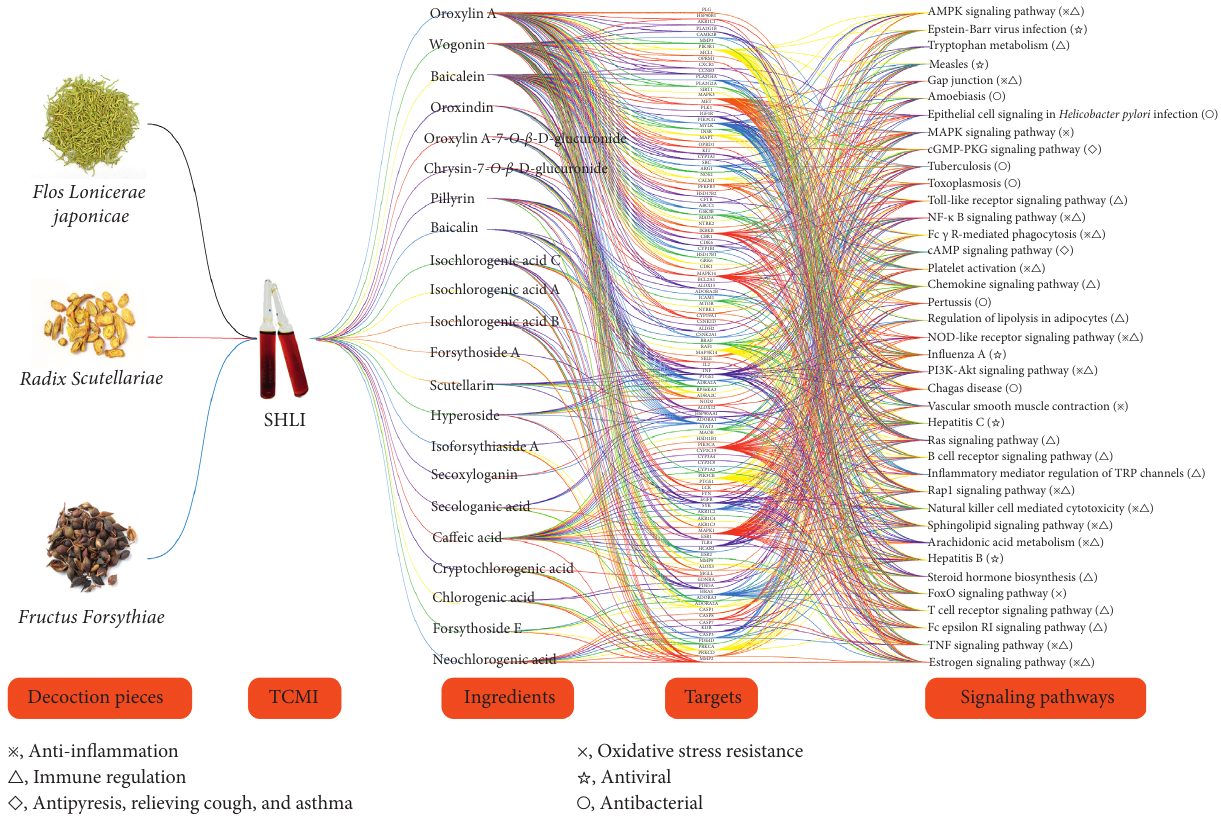
Figure 3: Parallel coordinate plot for the herbs-injection-compounds-targets-signaling pathways-pharmacological activity of